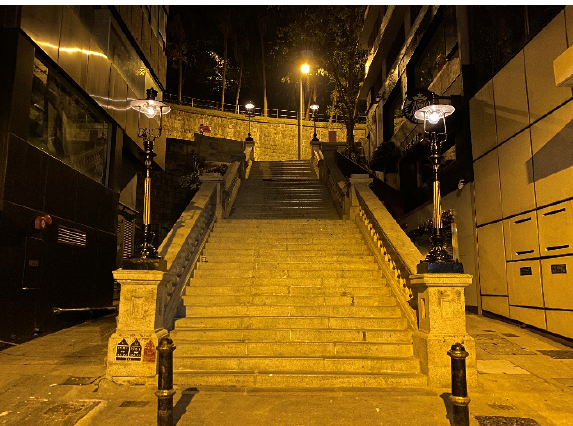
Figure 12: The Steps after restoration works completed.